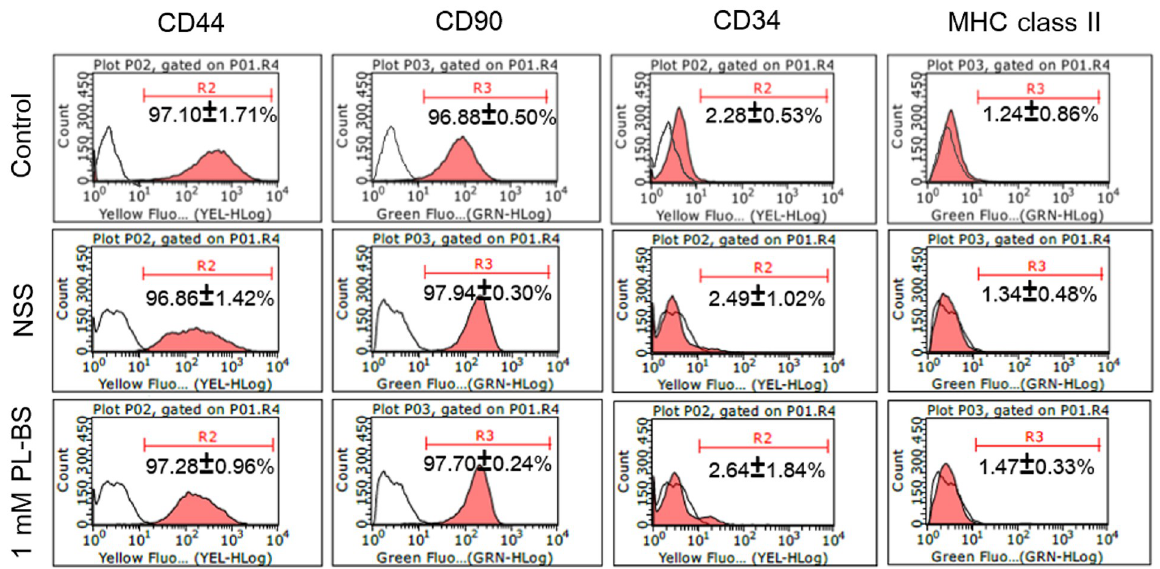
Fig 1. Expression of specific surface antigens of canine adipose-derived mesenchymal stem cells in different conditions. The stored cAD-MSCs highly expressed CD44 and CD90 but were deprived of CD34 and MHC class II, which was similar to the control group.